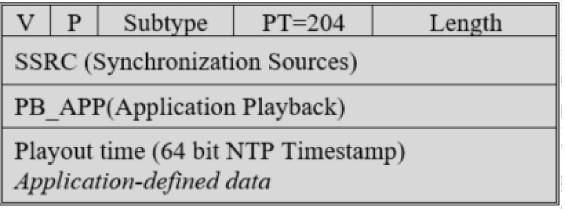
Figure 9. RTCP-APP: Application-defined RTCP packet, to carry Playout time from the sender.